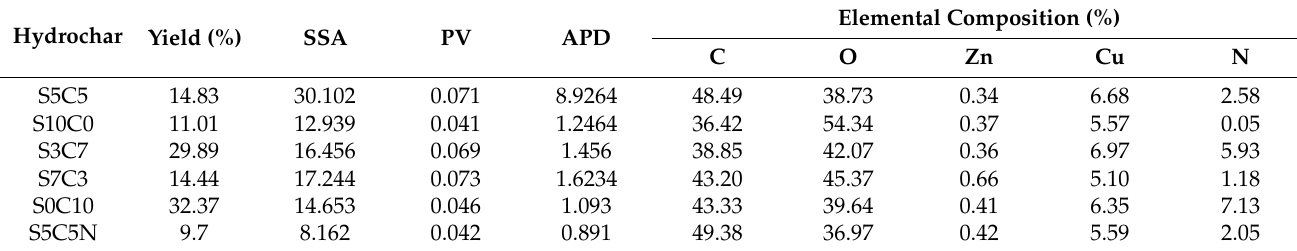
Table 1. The yields, specific surface area, average pore diameter, and elemental composition of the synthesized hydrochars. Hydrochar Yield